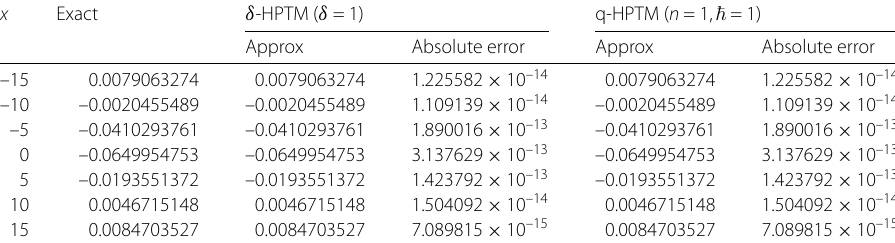
Table 4 The comparative study of Im[ W (3) ] solutions of δ -HPTM, q-HATM, and exact solution